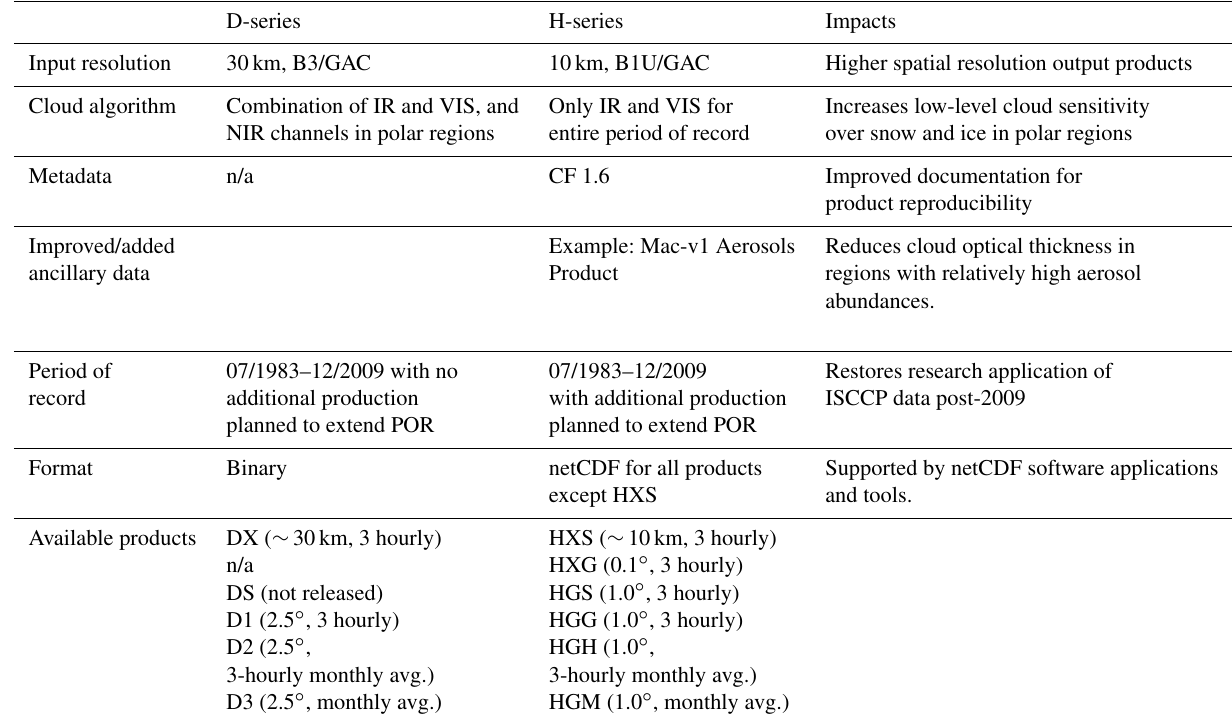
Table 2. High-level summary of differences between ISCCP D-series and H-series products and their impacts. Other details on differences are provided in the C-ATBD; n/a: not